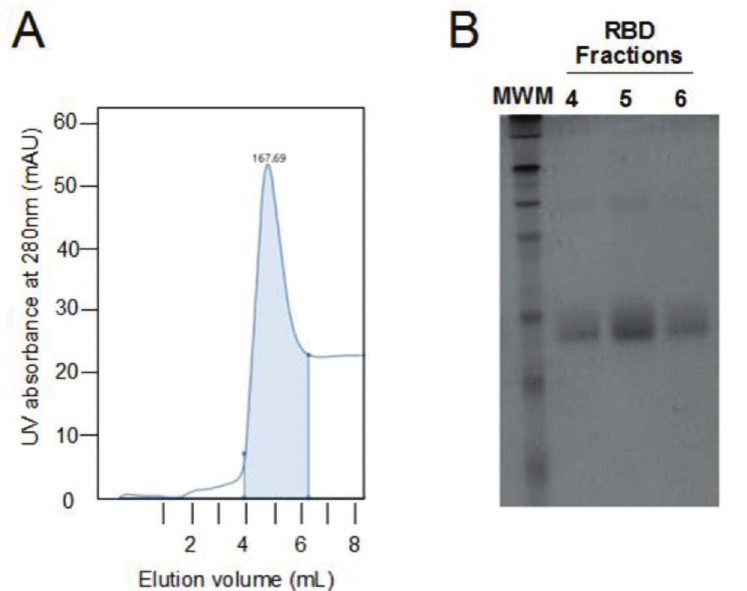
Figure S3 - Chromatographic purification and SDS-PAGE of the SARS-CoV-2 RBD protein (Wuhan strain). The full-length SARS-CoV-2 RBD protein was purified through affinity chromatography (A). UV absorbance at 280 nm (mAU) was monitored over time, and fractions corresponding to the RBD protein (blue area in the graph) were collected. Protein purity was assessed through electrophoresis of the final collected fractions (B), showing that the RBD protein exhibits a molecular weight of 30.6 kDa. The molecular weight marker (MWM) used was the ColorPlus Prestained Protein Marker, Broad Range (7-175 kDa) (Thermo Fisher Scientific).